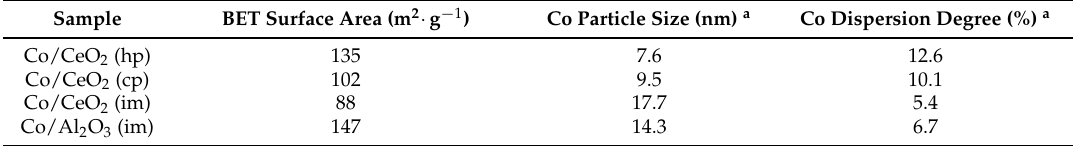
Table 1. Physical characters of various Co-supported catalysts with 7.7 wt. % Co loading. Sample